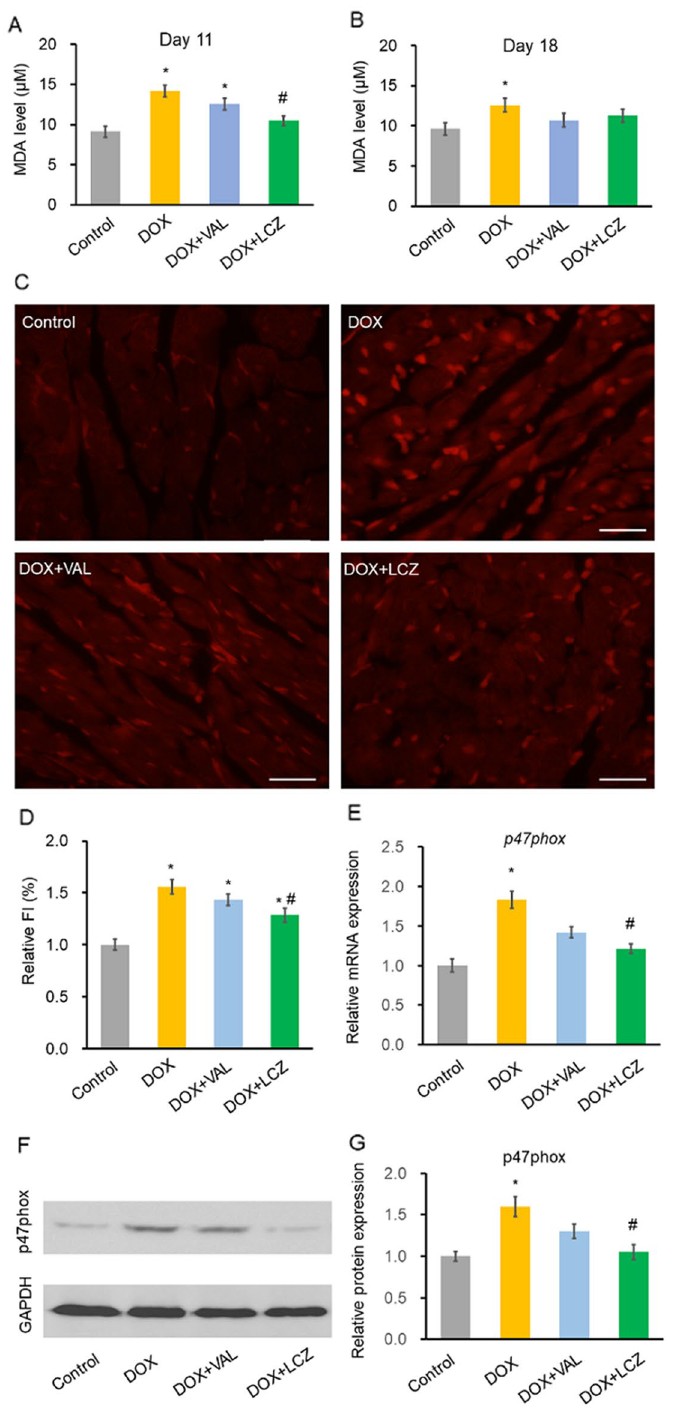
Figure 2. Effect of valsartan and LCZ696 on serum malondialdehyde (MDA) levels and oxidative stress in rat hearts treated with doxorubicin. ( A ) On day 11, DOX significantly increased the serum MDA level which was significantly reduced by LCZ, but not VAL. n = 15 in each group. ( B ) On day 18, DOX significantly increased the serum MDA level, which was not reduced by LCZ and VAL. n = 10–15 in each group. ( C ) Representative DHE staining on day 18 in each group. ( D ) Oxidative stress in the cardiac tissue was measured based on the fluorescence intensity of DHE. LCZ, but not VAL, significantly reduced the DOX-induced oxidative stress. Five random fields from three random samples per group were re-evaluated for the analysis. ( E ) Real-time PCR to check for the expression of p47phox day 18. DOX significantly increased p47phox mRNA expression. This increase was significantly reduced by LCZ, but not VAL. Data are presented relative to the control group. n = 10–15 in each group. ( F ) Representative Western blot images of the expression of p47phox in the cardiac tissue on day 18. ( G ) Protein expression of p47phox as measured by western blotting. DOX significantly increased the level of p47phox which was significantly reduced by LCZ, but not VAL. Data are presented relative to the control group. Five random samples per group were re-evaluated for the analysis. Data are expressed as the mean ± standard error. Scale bars, 50 μm. * p < 0.05 versus control and # p < 0.05 versus DOX. MDA, malondialdehyde; DOX, doxorubicin; VAL, valsartan; LCZ, LCZ696; DHE, dihydroethidium; FI, fluorescence intensity; TNF, tumor necrosis